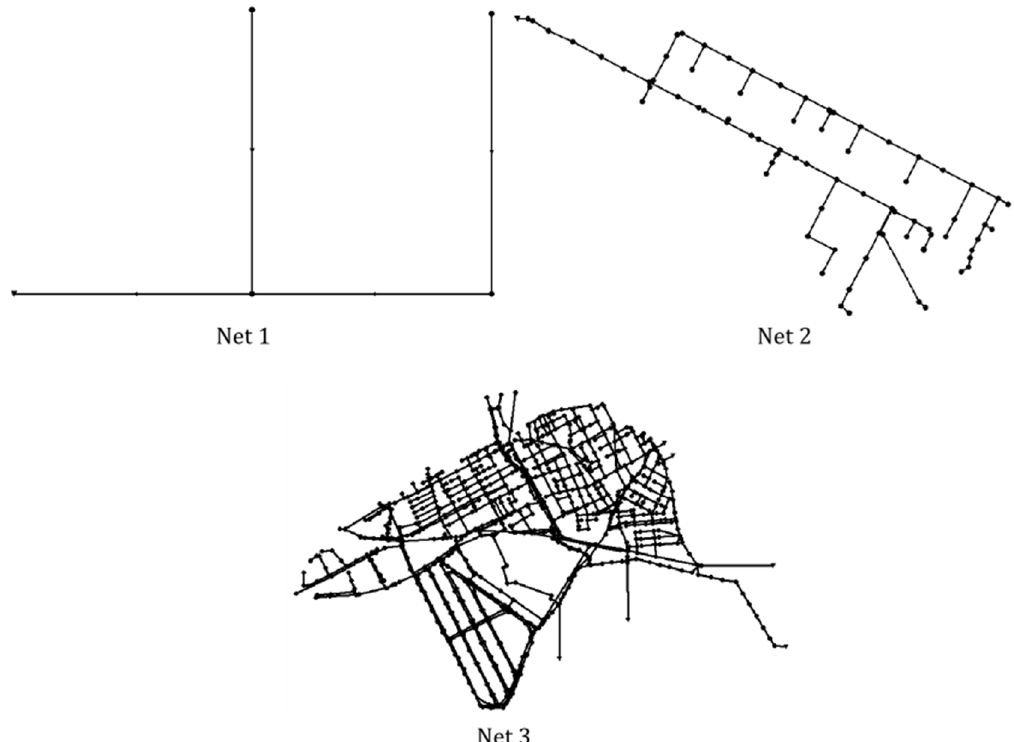
Figure 3. Networks used for calculation time evaluation.